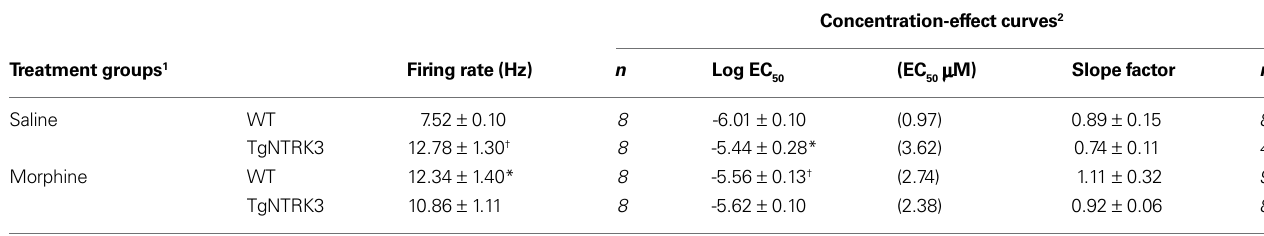
Concentration-effect curves 2